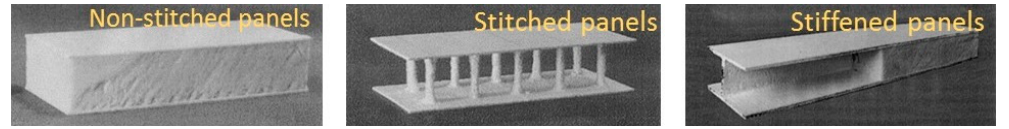
Figure 11. Configurations of 3 types of specimens. Adapted from [54].